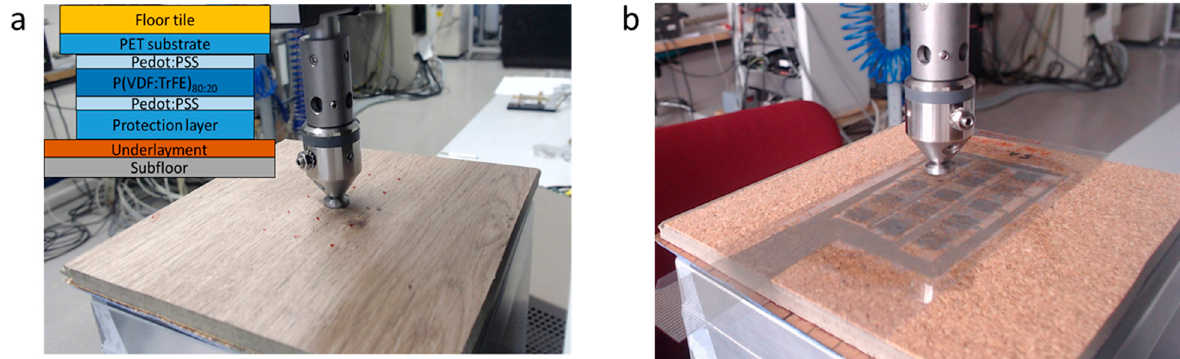
Figure 3. Experimental setup for testing the smart floor tile: ( a ) upper side and ( b ) flipped side. The pressure stamp applies up to 90 N with a 1 cm 2 circular stamp head. The red dots in ( a ) are visual guides for performing the experiment and indicate the center points of each pixel. The scheme in the insert shows the layer stack of the whole setup. The floor tile is 8 mm thick. ( b ) Printed sensor matrix glued to the bottom side of the floor tile.